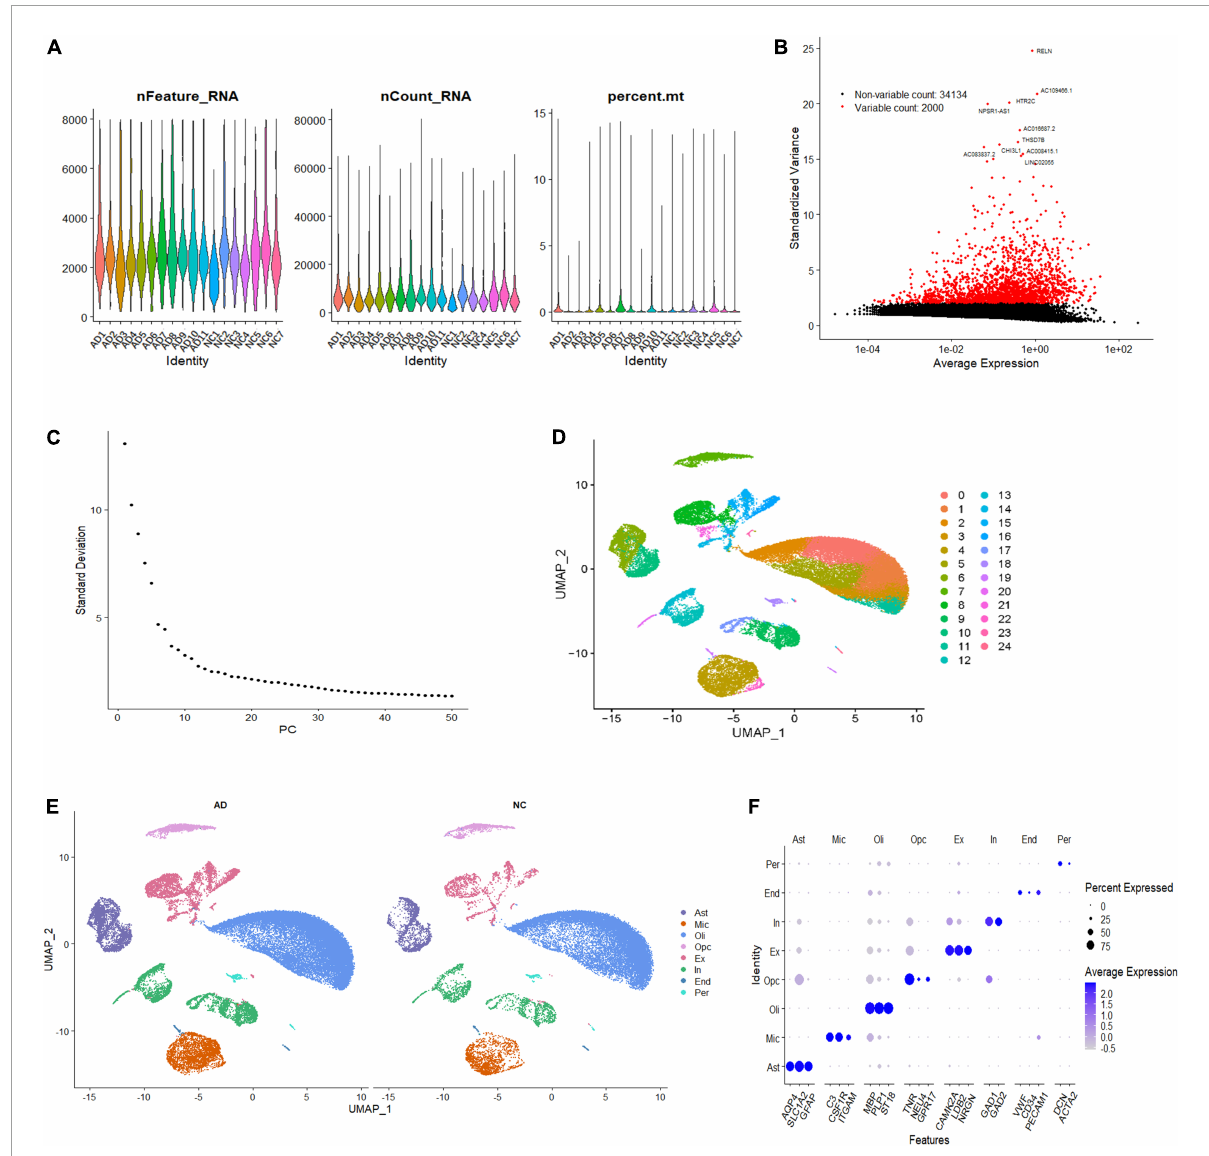
FIGURE1 Single-nucleus transcriptome analysis of the human AD prefrontal cortex. (A) The gene features, counts, and mitochondrial gene percentage of each sample. (B) HVGs were identified and colored in red, and the top ten HVGs were labeled. (C) PC selection using Elbowplot function. (D) UMAP plot analysis showing 25 major cell clusters based on gene expression profile. (E) UMAP projection of overall cell types of AD and NC samples, respectively. Different cell types were colored with unique colors. (F) Dot plot of marker gene expression of each cell type. The dot size represents the percentage of cells expressing selected genes, and the dot color represents average expression. AD, Alzheimer’s disease; Ast, astrocyte; End, endothelial cell; Ex, excitatory neuron; HVGs, highly variable genes; In, inhibitory neuron; Mic, microglia; NC, normal control; Oli, oligodendrocyte; Opc, oligodendrocyte progenitor cell; PC, primary component; Per, pericyte; UMAP, uniform manifold approximation and